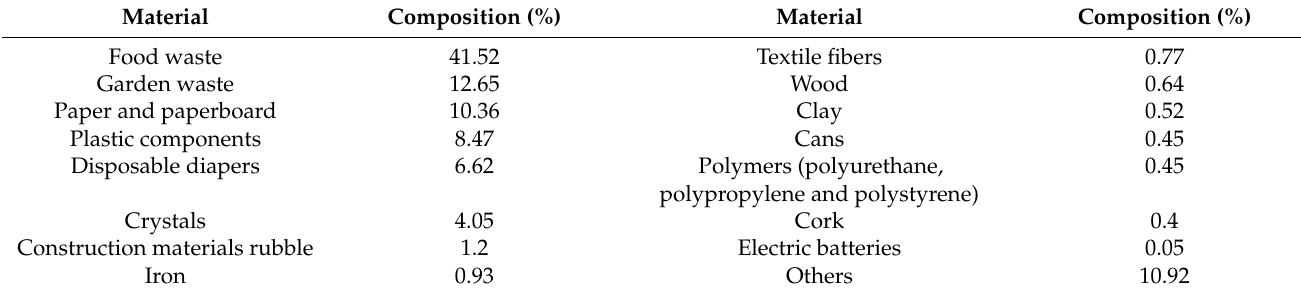
Table 2. Average composition of USW